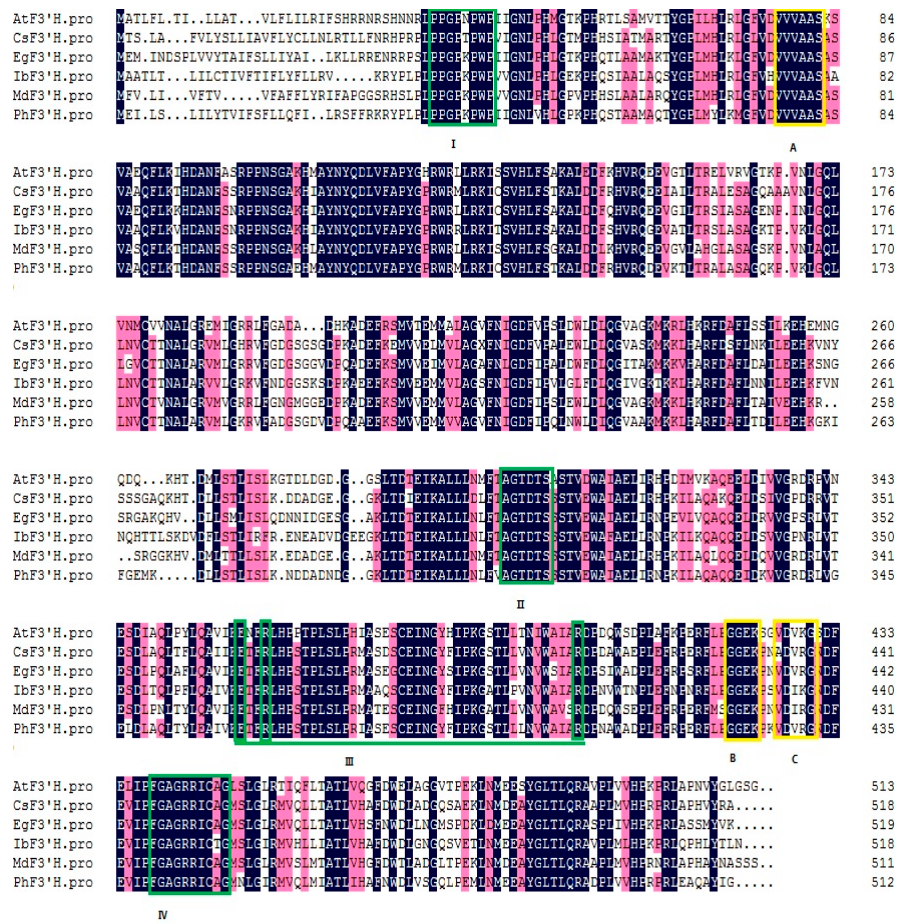
Figure 2. Multiple sequence alignment of the CsF3’H protein and five flavonoid 3’-hydroxylases (F3’Hs). Besides CsF3’H, other amino acid sequences included in this alignment were AtF3’H